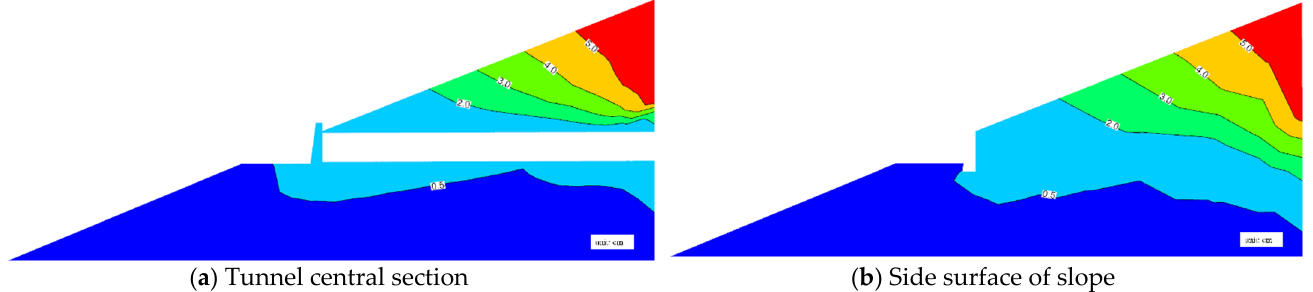
Figure 9. Soil displacement field after loading.